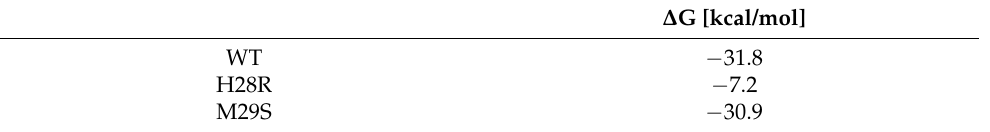
Figure 3. Molecular dynamics (MD) simulations of the CDV-H-macaca SLAM complex. ( a ) RMSD values for C α atoms during the 100 ns MD simulations. The RMSD values for WT and the H28R and M29S variants are shown in black, red, and blue, respectively. ( b ) RMSFs for residues (from 25 to 31) in the N -terminal region of macaca SLAM. The color code is the same as in ( a ). ( c ) Trajectory structures of the CDV-H-macaca SLAM complex. The N -terminal region is more flexible than other regions of the complex. Table 1. Interaction energies between macaca SLAM and CDV-H by MMGBSA